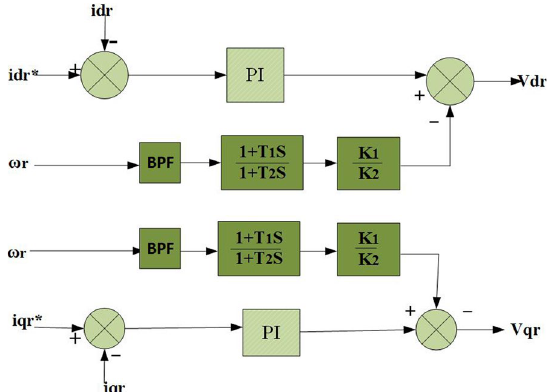
Fig. 13 Feedback filtering (LLC and BPF)